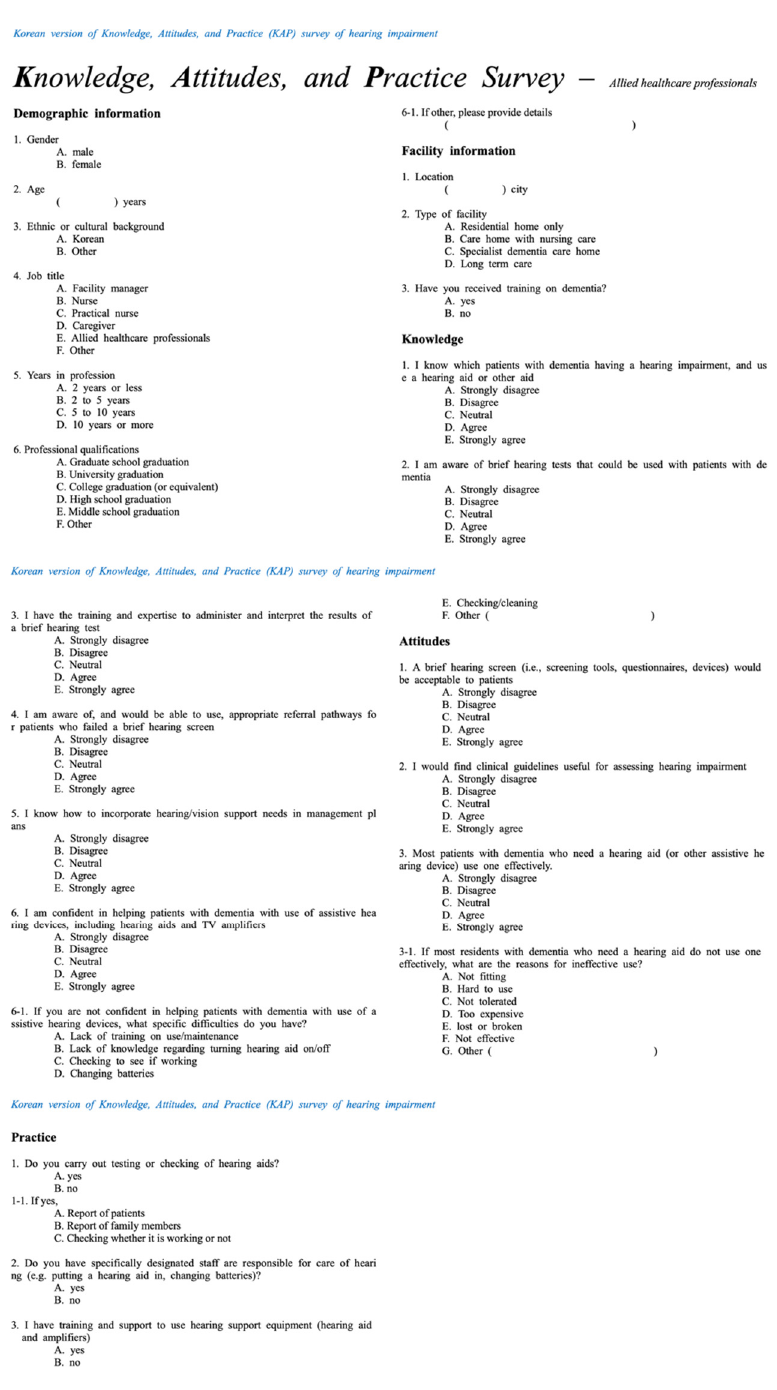
Figure A2. K-KAP survey for allied healthcare professionals.